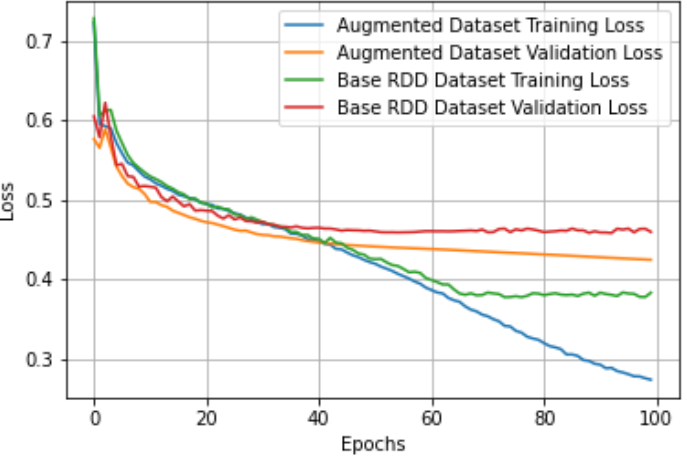
Figure 10. Training and validation loss curves for the augmented and RDD base